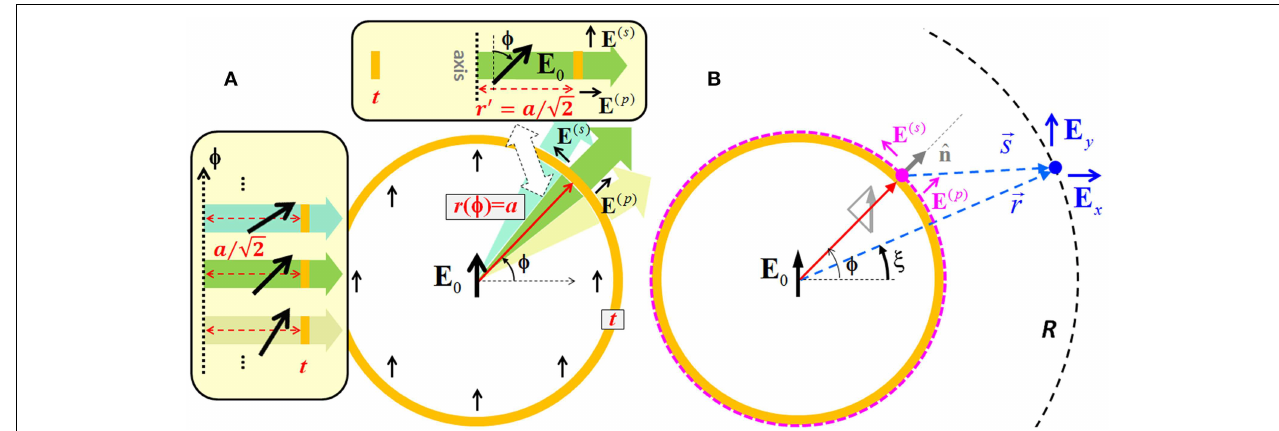
FIGURE 2 | (A) Geometry transformation from a circular ring ARF to a series of slab waveguides. r and r ′ represent the inner radii’s of the fiber and the slab respectively. (B) Evaluating and integrating the outward-propagating electromagnetic waves in the transverse plane by using Green’s theorem.